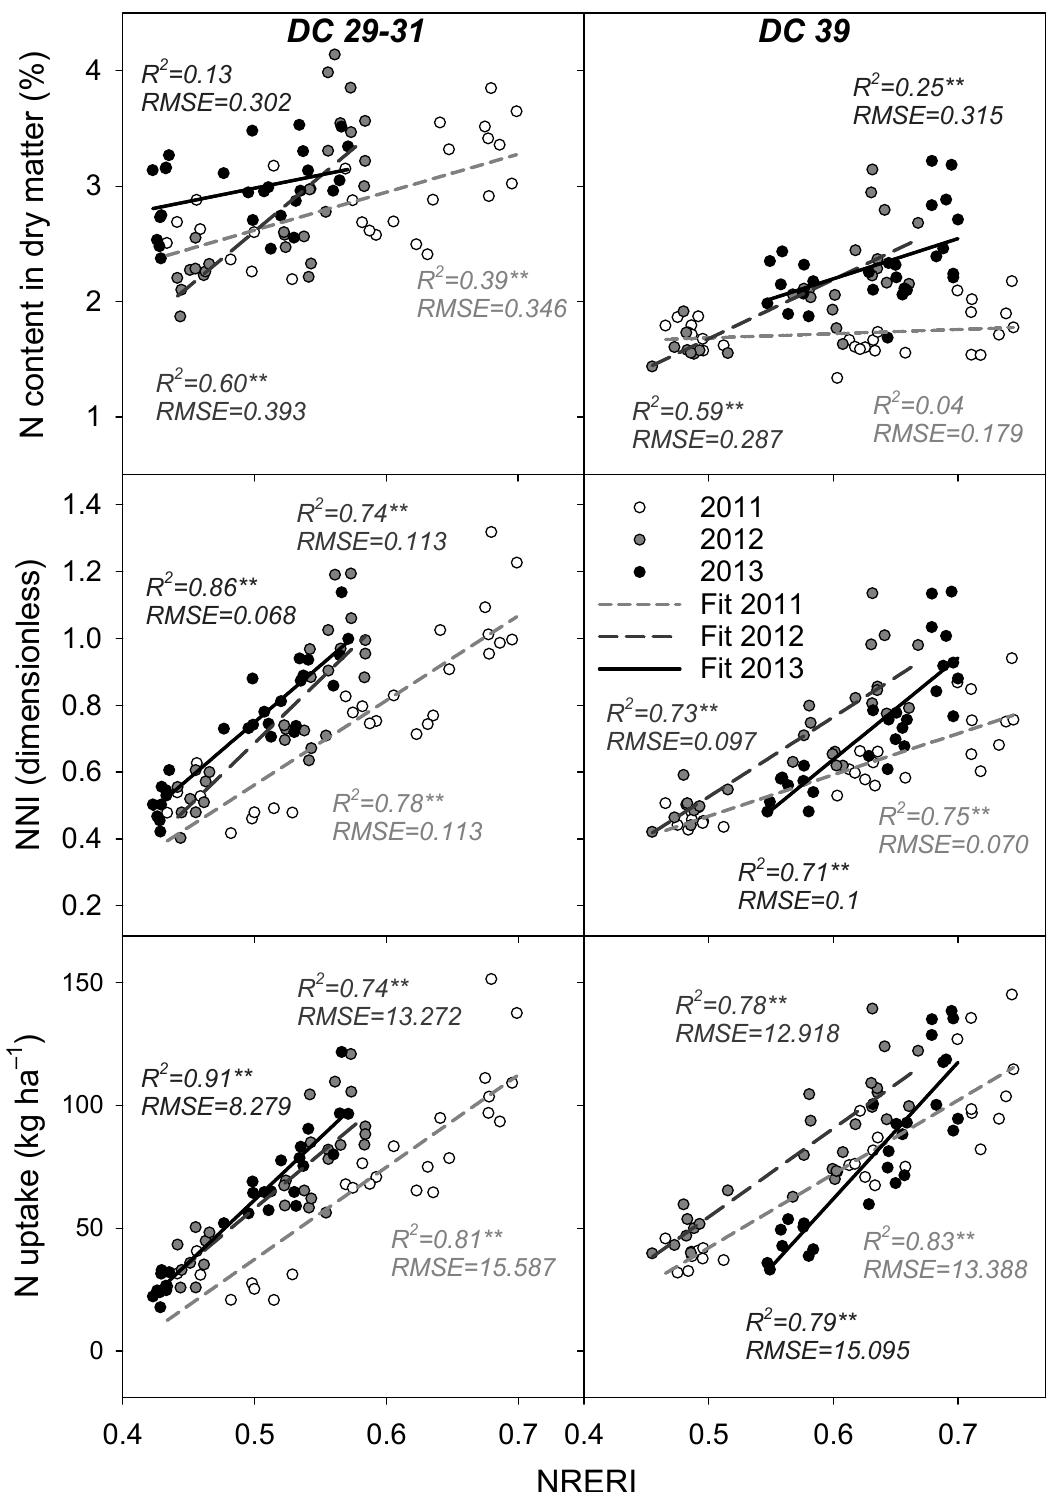
Figure 3. Linear relationships between reflectance index NRERI and nitrogen content in aboveground dry mass ( upper ), nitrogen nutrition index (NNI, middle ), and nitrogen uptake by aboveground biomass per area unit ( lower ), analyzed separately for growth stage beginning of stem elongation (DC 29–31, left ) and end of stem elongation (DC 39, right ), and for individual years (2011—white points and light grey line, 2012—grey points and dark grey line, and 2013—black points and black line). Coefficients of determination ( R 2 ), root mean square errors (RMSE), and significant correlations (* at p < 0.05 and ** at p < 0.01) are indicated for each relationship.